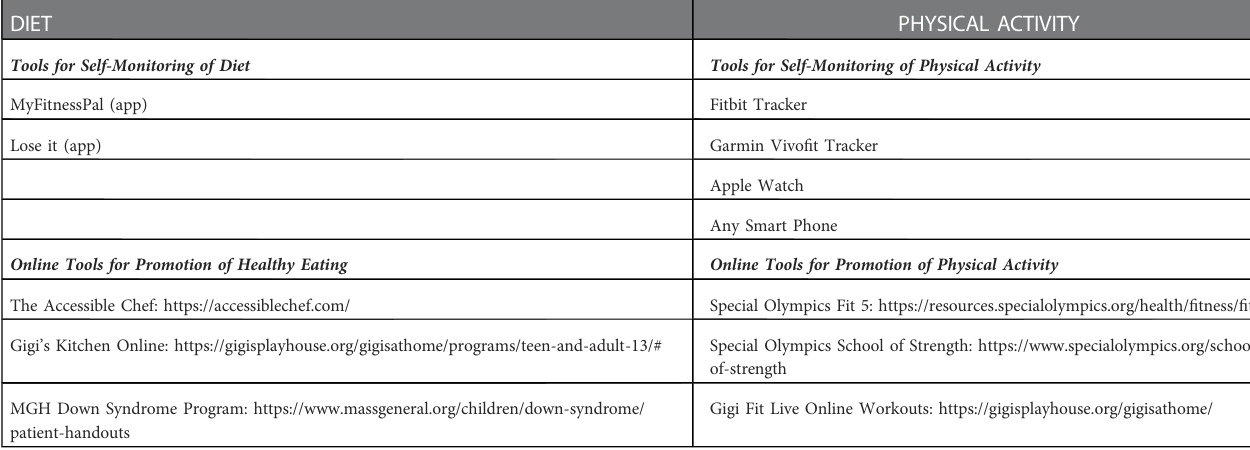
TABLE 4 Technology based tools for self-monitoring and online programs for the promotion of health eating and physical activity. DIET Tools for Self-Monitoring of